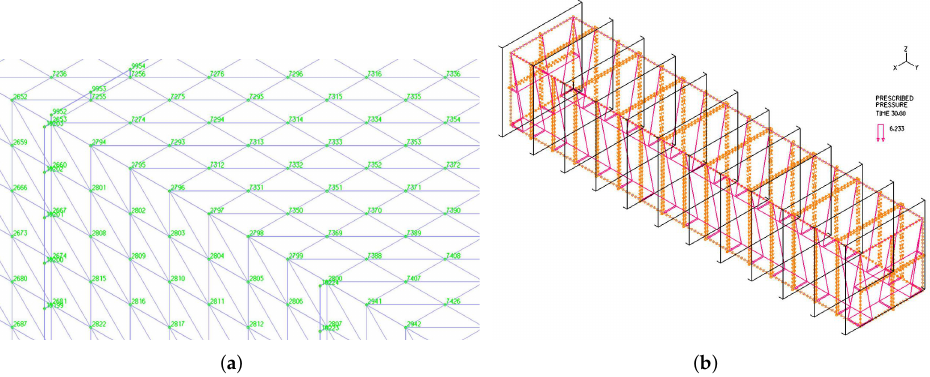
Figure 15. ADINA simulation of the full-fledged three-dimensional plate and beam model with stiffeners. ( a ) Stiffeners and rigid links, ( b ) Linear pressure